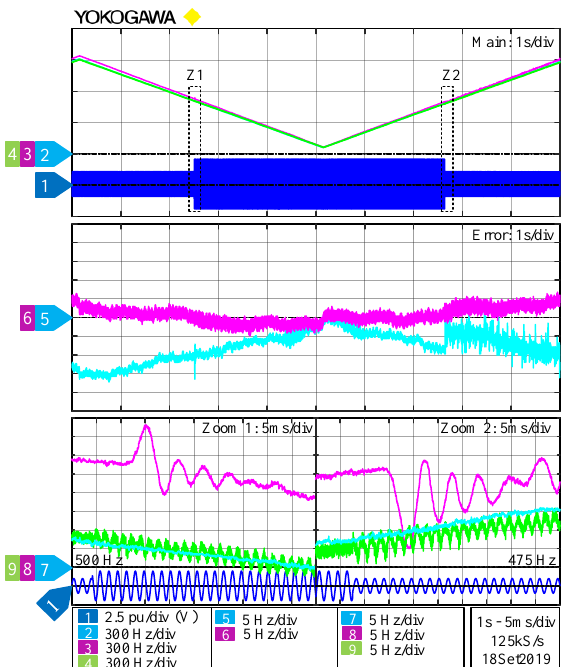
Figure 22. Experimental results related do Test 1—frequency ramp ( ± 188 Hz / s) and voltages steps 1-